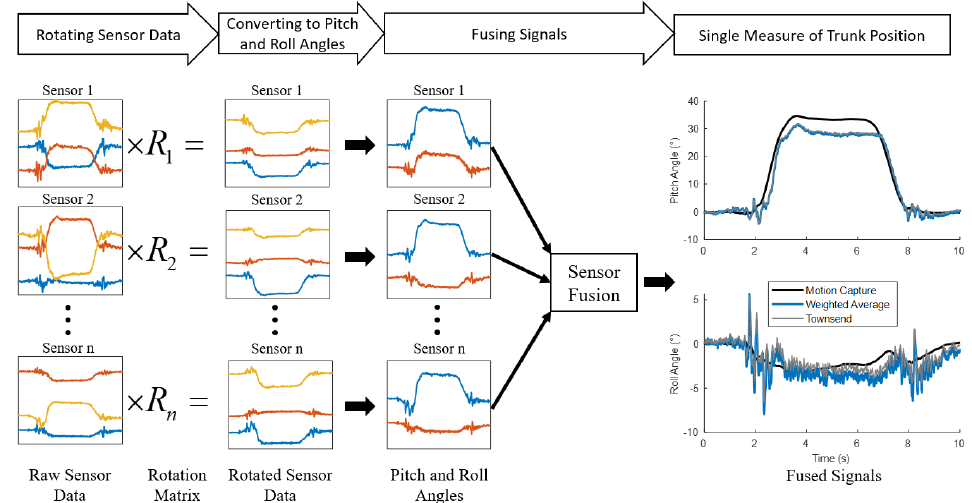
Figure 4. Overview of the sensor rotation and fusion process. Signals from each accelerometer are first rotated, then converted to pitch and roll angles. Finally, the pitch and roll angles from every sensor are fused into a single measure of trunk